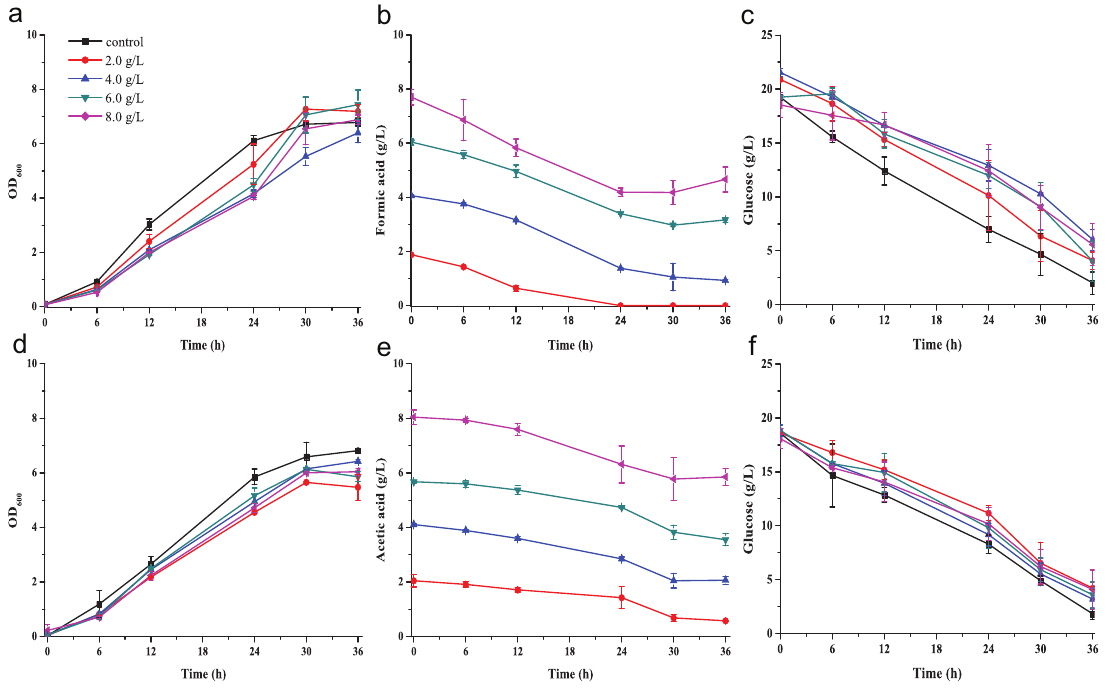
Figure 2. Degradation of formate/acetate by K. huakuii LAM0618 T in a rich medium. Growth curve of K. huakuii LAM0618 T , formate/acetate degradation curve and glucose consumption curve in a rich medium (pH6.0) containing formate ( a – c ) and acetate ( d – f ) at 2.0, 4.0, 6.0, and 8.0 g/L, respectively. All experiments were performed in duplicate and results are presented as mean ± SD. Error bars indicate